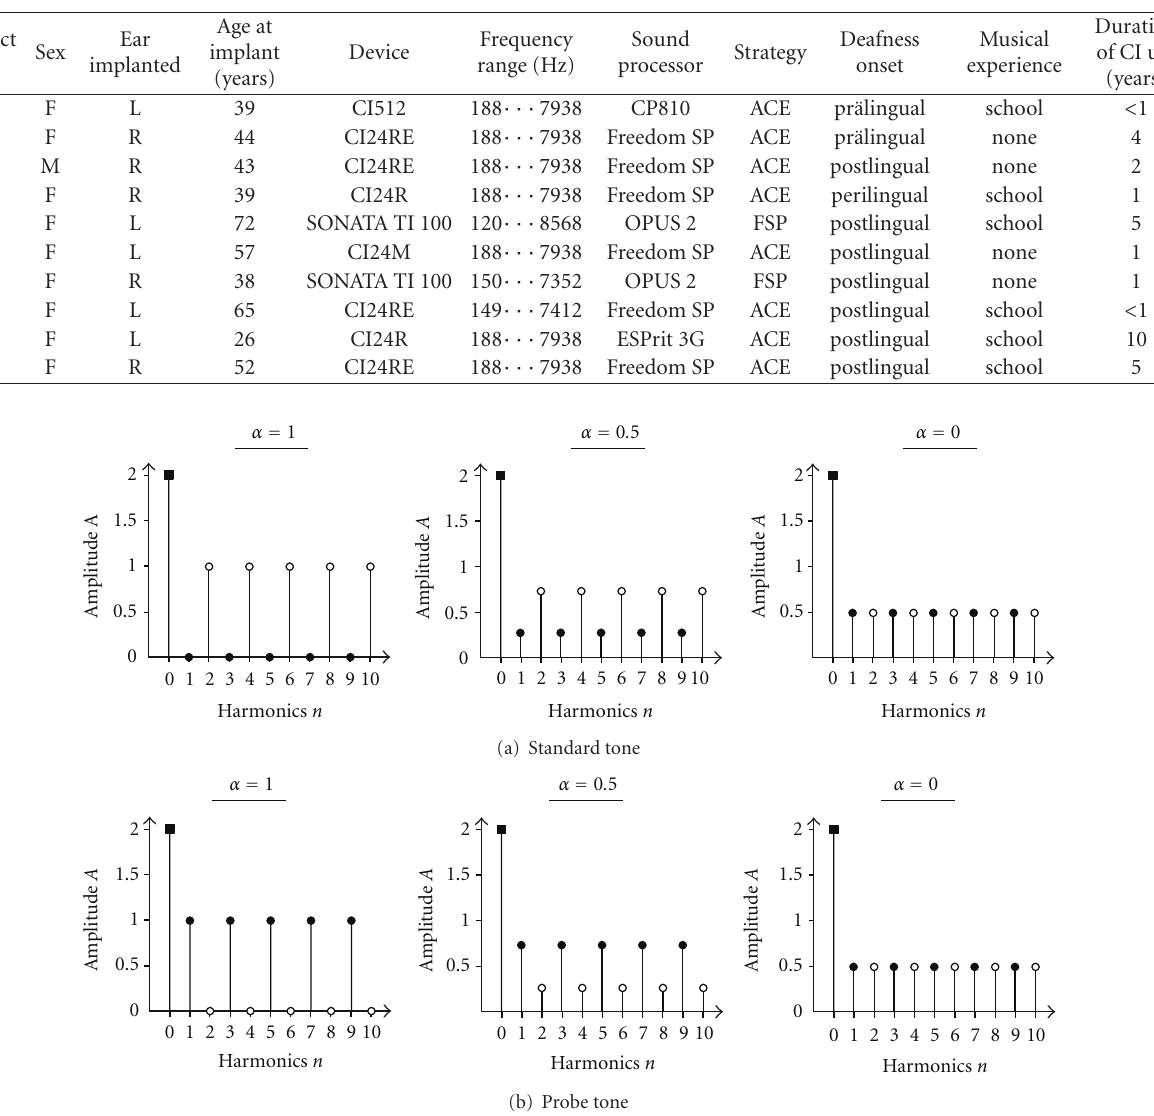
Table 1: CI user demographics.